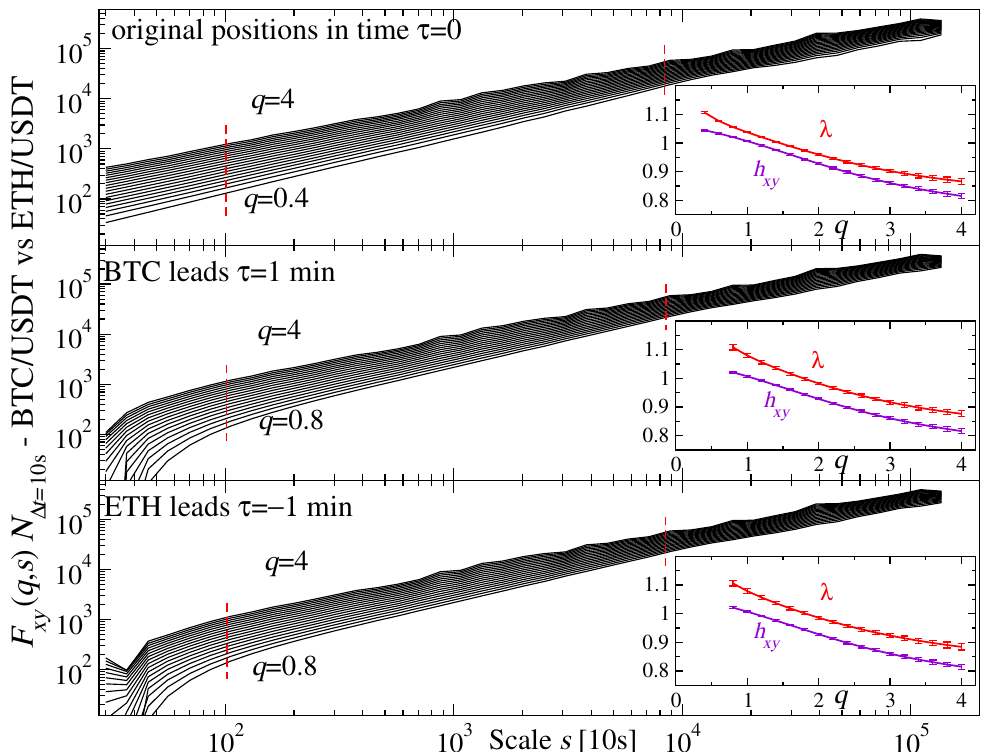
Figure 7. ( Main panels ) Fluctuation functions F XY q ( s ) calculated for time series of the number of transactions N ∆ t ( t ) in ∆ t for X = BTC and Y = ETH. In each panel, vertical dashed lines denote a range of time scales s for which a power-law model can be fitted to F XY q ( s ) . Extreme values of q are also shown. Three cases are considered: both time series are simultaneous ( top ), time series representing BTC is advanced by τ = 1 min ( middle ), and time series representing ETH is advanced by τ = 1 min ( bottom ). ( Insets ) The bivariate scaling exponent λ ( q ) vs. the mean univariate scaling exponent h XY ( q ) calculated for the same time series. Error bars denote the standard